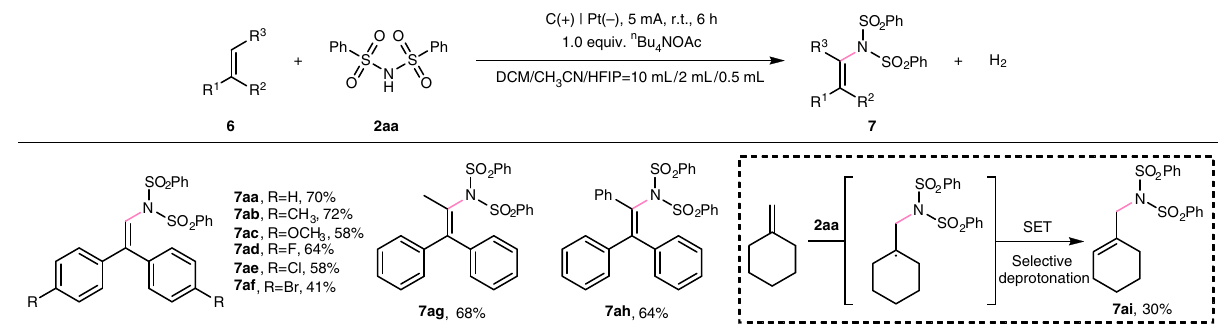
Fig. 5 Electrochemical oxidation-induced dehydrogenative imidation of alkenes. Reaction conditions: carbon rod anode, platinum plate cathode, constant current = 5 mA, 6 (0.40 mmol), 2aa (0.60 mmol), n Bu 4 NOAc (0.40 mmol), solvent (DCM/CH 3 CN/HFIP = 10 mL/2 mL/0.5 mL), undivided cell, N 2 , 6 h. Isolated yields.